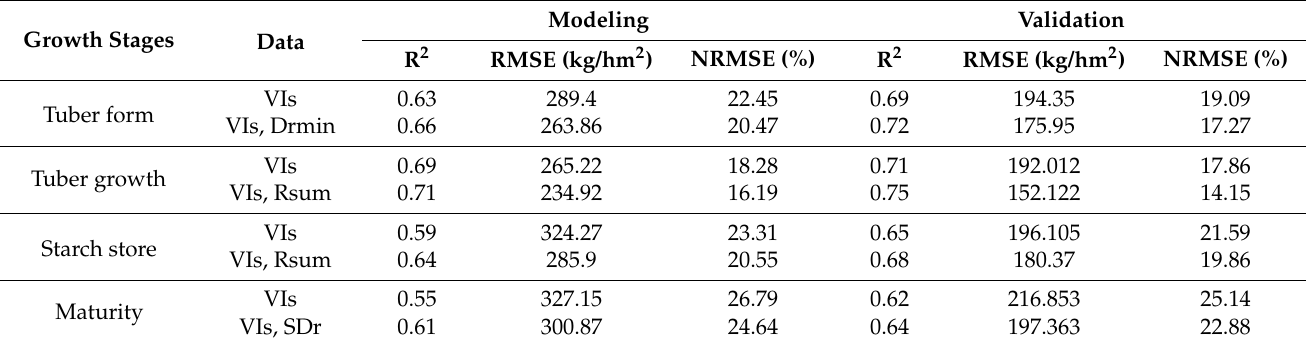
Table 7. RF-based estimates of potato AGB at different growth